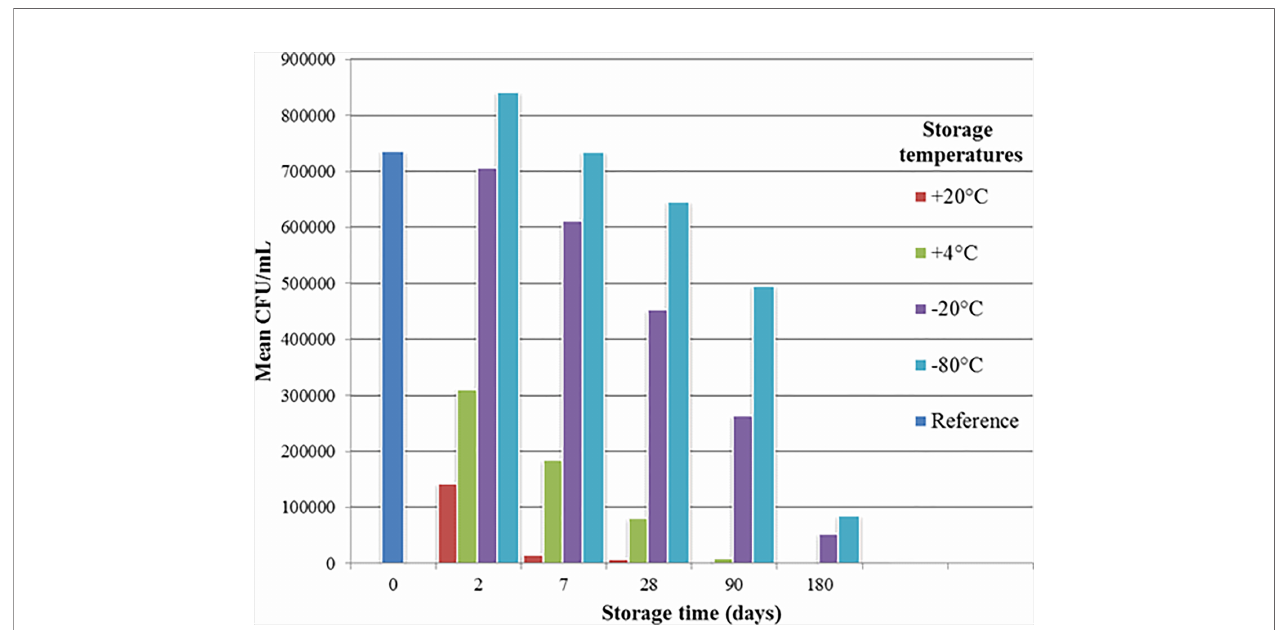
FIGURE 4 | Survival of bacteria depending on the temperature of storage. CFU, Colony-Forming